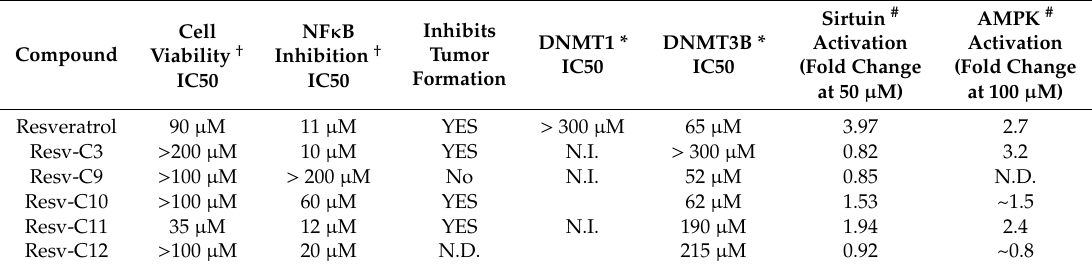
Table 1. Summary of biological properties of resveratrol and derivatives. Table showing a summary of the biological properties characterized in this study for the most e ff ective salicylate resveratrol derivatives as determined in this study and other